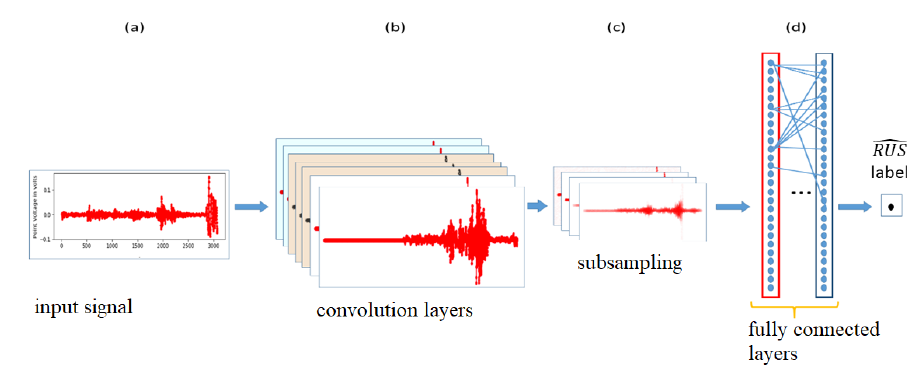
Figure 10. Workflow Schema of our CNN models. ( a ) Normalized Input is a 1-dimensional array of 3072 values. ( b ) Kernels of 1D-CNN layers convolve over input x. ( c ) Outputs of 1D-CNN layers are fed to a pooling layer. ( d ) Subsampled outputs are provided to fully connected layers, which then output a remaining useful strength (RUS) value.